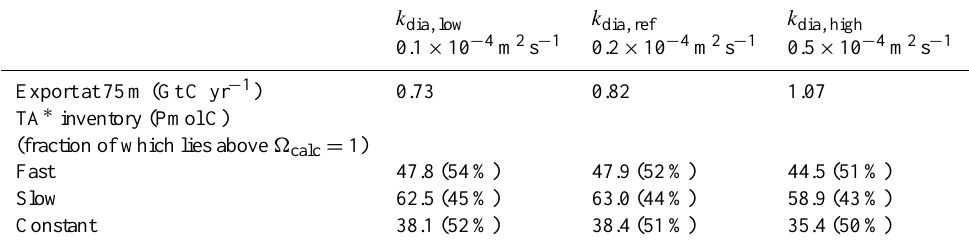
Table 2. Results from sensitivity simulations. CaCO 3 export and TA ∗ inventories for different physical mixing (diapycnal mixing coefficient, k dia ) and CaCO 3 dissolution schemes. For these illustrative simulations, calcite and aragonite particles were assigned equal parameter values and 10% of export is assumed to be in the form of aragonite. Fast: k 0 = 10day − 1 , n = 1, f calc = 0 . 9, k bg = 0; slow: k 0 = 0 . 16day − 1 , n = 2, f calc = 0 . 9, k bg = 0; constant: k bg /v = 1 / 2900m − 1